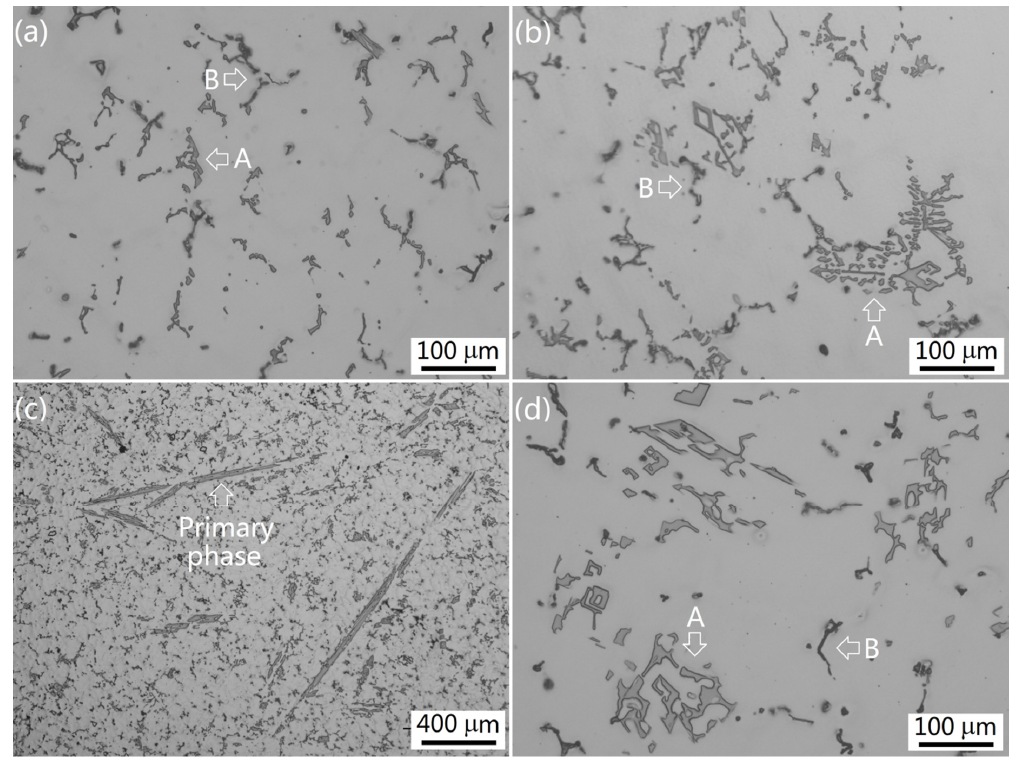
Figure 4. The as ‐ cast microstructures of the Group II alloys solidified under near ‐ rapid cooling Figure 4. The as-cast microstructures of the Group II alloys solidified under near-rapid cooling ( a ) Alloy II ‐ 1; ( b ) Alloy II ‐ 3; ( c , d ) Alloy II ‐ 4. ( a ) Alloy II-1; ( b ) Alloy II-3; ( c , d ) Alloy II-4.